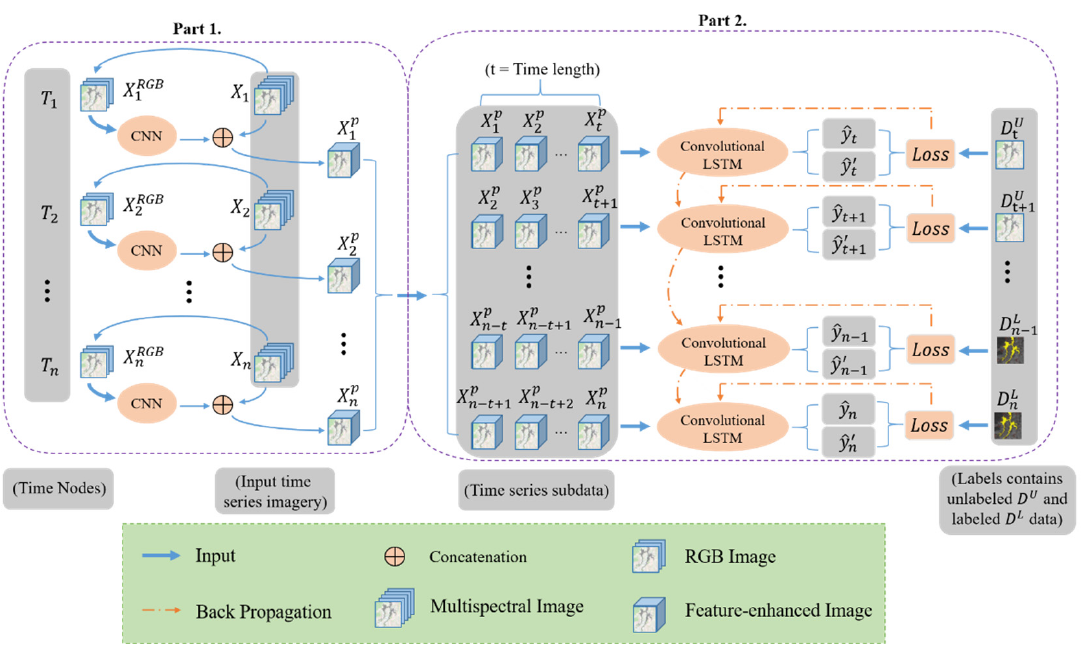
Figure 1. The framework overview of the proposed SemiLSTM model for land cover classification in time series images.